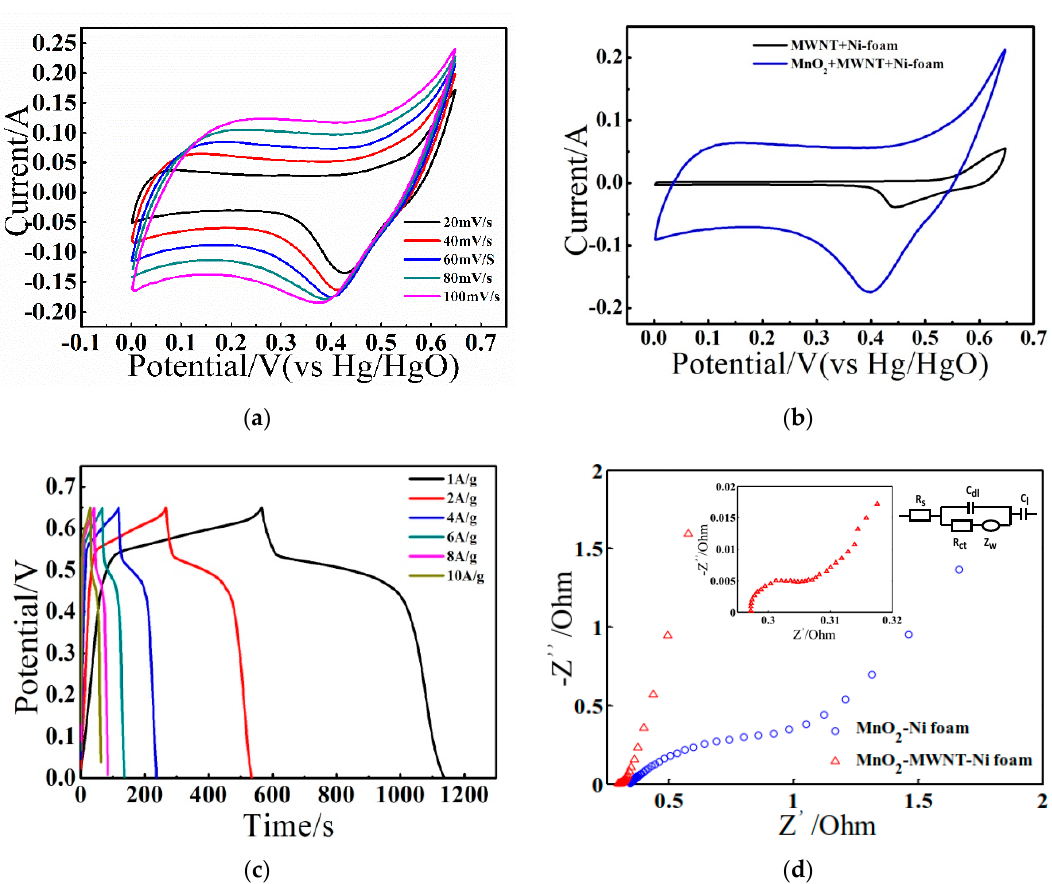
Figure 4. ( a ) Cyclic voltammetrys (CVs) of the MnO 2 –MWNT–Ni foam electrode at different scan rates. ( b ) CV comparison of the CNT–Ni foam electrode and the MnO 2 –MWNT–Ni foam electrode at 50 mV/s. ( c ) Charge/discharge curves of the MnO 2 –MWNT–Ni foam at different current densities in the electrochemical workstation. ( d ) Electrochemical impedance spectroscopy (EIS) curves of the MnO 2 –Ni foam and MnO 2 –MWNT–Ni foam electrodes tested in 6 M KOH.